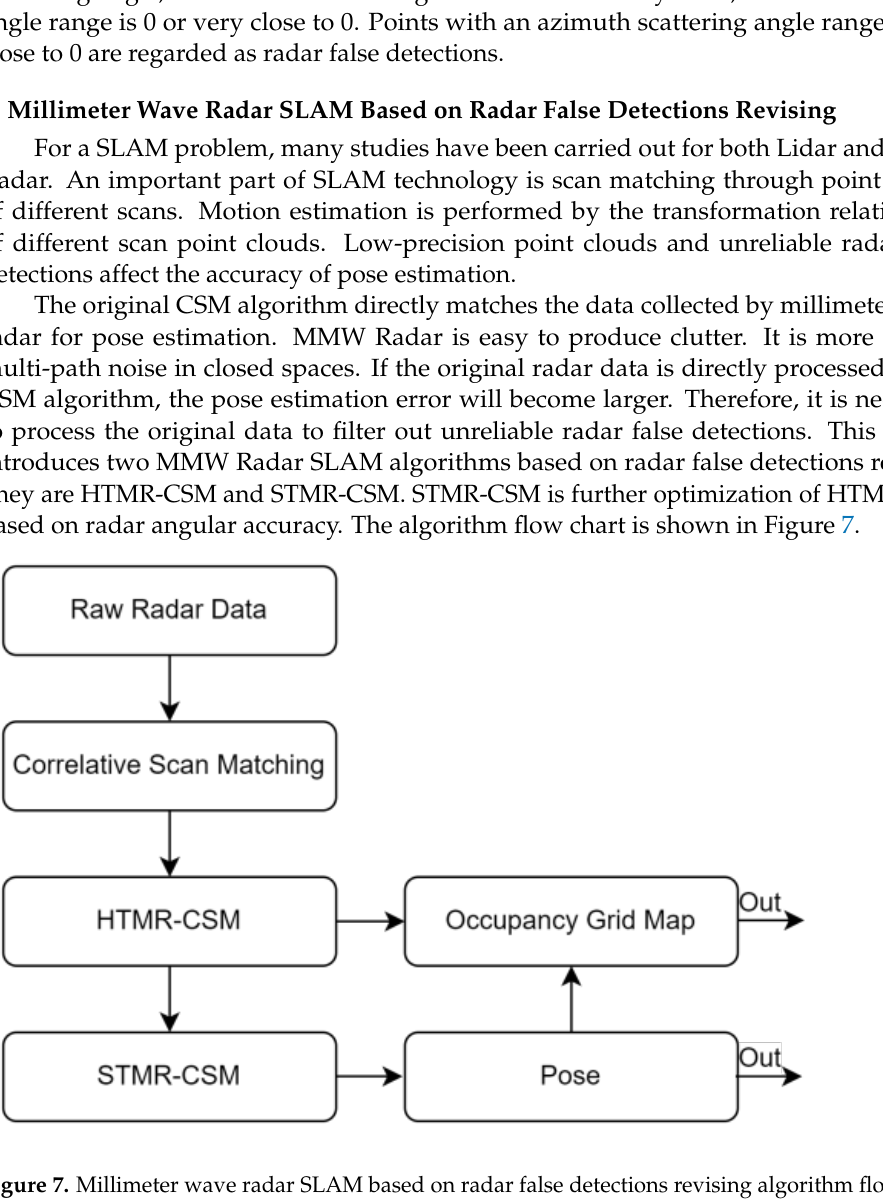
Figure 7. Millimeter wave radar SLAM based on radar false detections revising algorithm flow